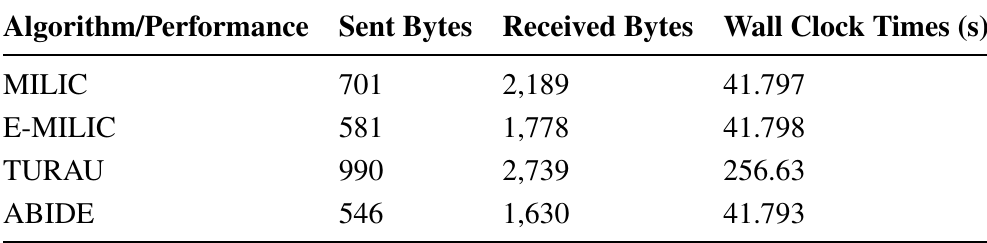
Table 3. Performance of algorithms in sparse